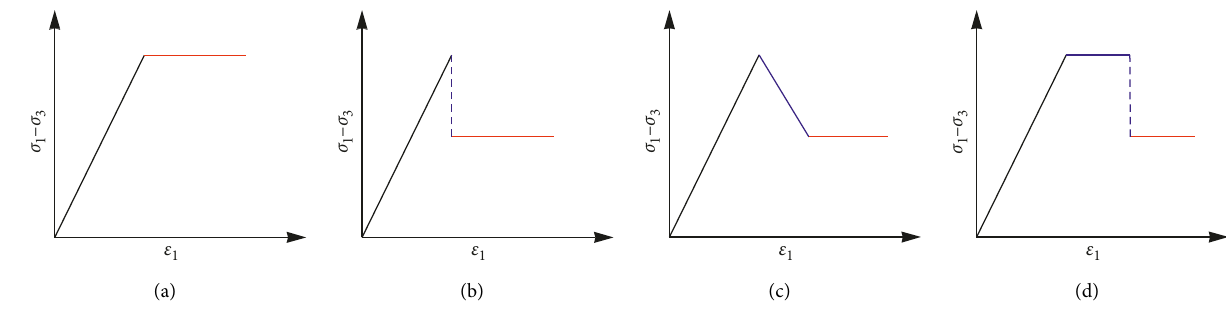
Figure 1: Simplified traditional constitutive models. (a) Elastic-plastic model (EPM). (b) Elastic-brittle-plastic model (EBM). (c) Elastic- strain-softening model (ESM). (d) Elastic-peak plastic-brittle plastic model